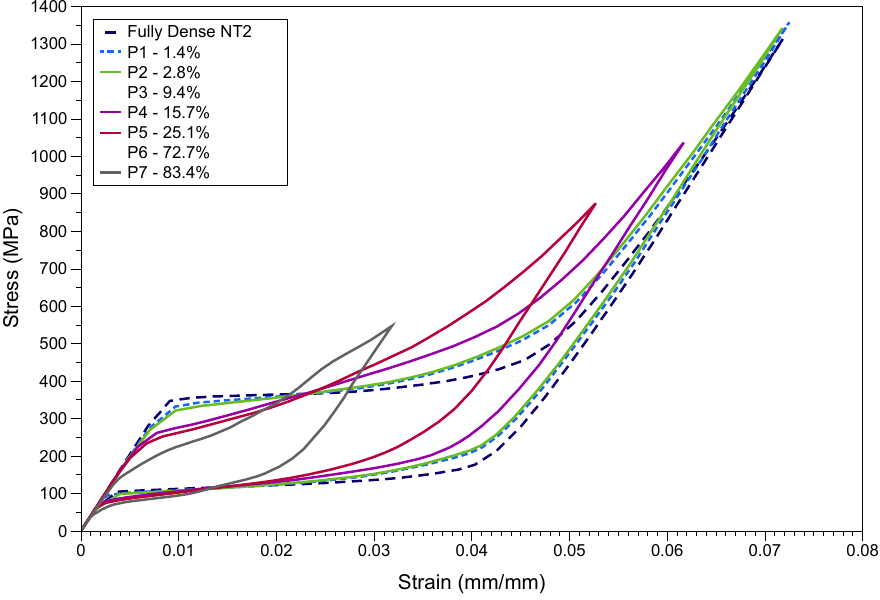
Figure 16. Simulated stress–strain curves for fully dense and porous NiTi structures.